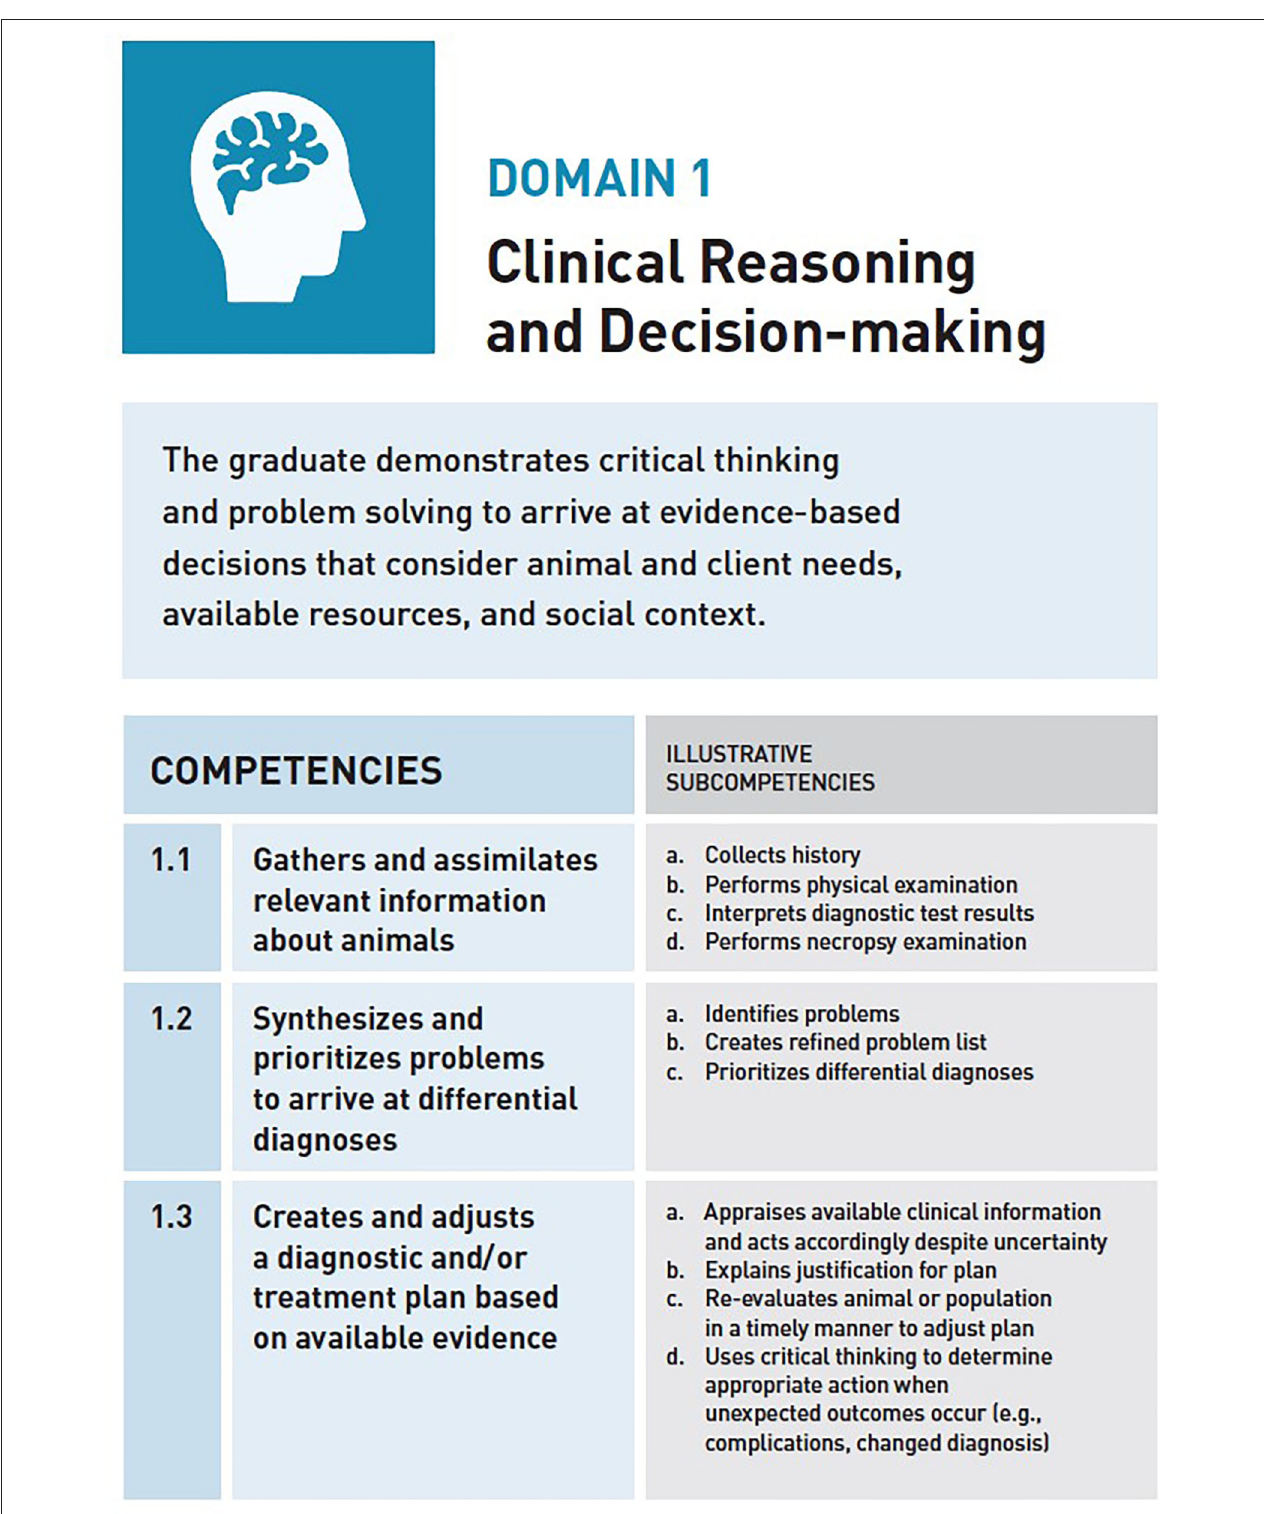
FIGURE 1 | CBVE Domain of Competence 1: Clinical Reasoning and Decision-Making, an example/excerpt of the framework representing competencies and Illustrative subcompetencies.